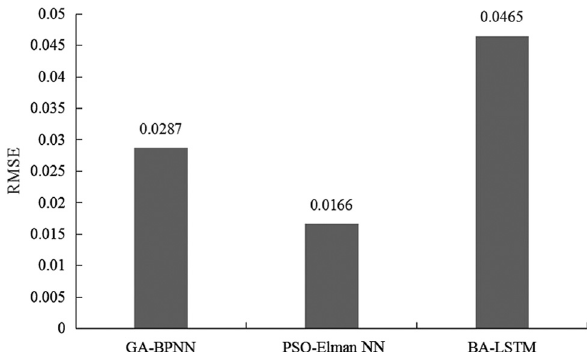
Figure 3: Comparison of RMSE values between di ff erent